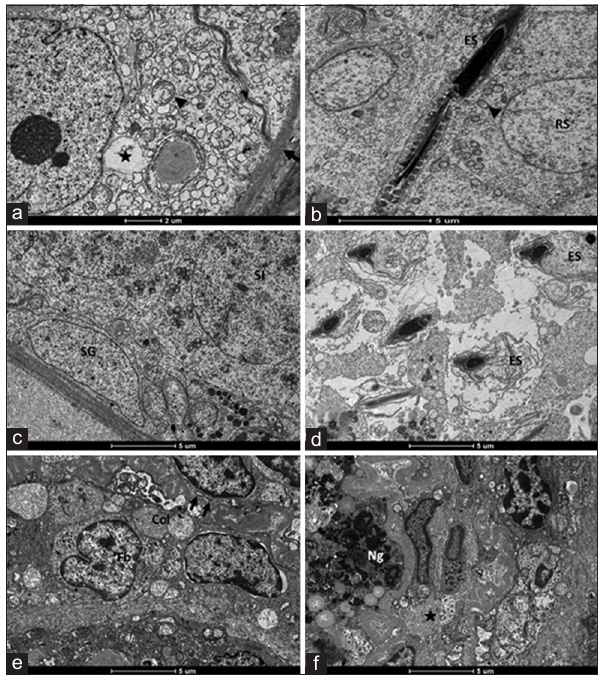
Figure-2: Transmission electron micrograph of testis in adult rats treated with intratesticular injection of a zinc- based solution and treated with different anti-inflammatory drugs (dipyrone + dexamethasone: (a and b); dipyrone + celecoxib: (c and d); dipyrone + DMSO: (e and f). (a) Note basal membrane thickness (arrow), Sertoli cell vacuolization (star) and mitochondria damage (arrowhead). (b) Observe elongated spermatid (ES) and round spermatids showing well-preserved structure but with mitochondria damage (arrowhead). (c) Note spermatogonia and spermatocytes I showing a well-preserved cell structure. (d) Swollen ES detached from Sertoli cell crypt. (e) Active fibroblast, collagen deposition in the intertubular tissue and thickening of basal membrane in an atrophied seminiferous tubule (arrow). (f) Intertubular fibrosis (star) and necrotic germ cell